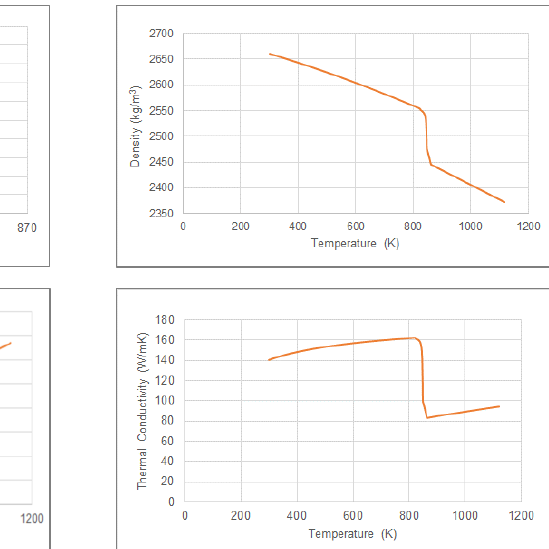
Figure 6. Thermo-physical properties obtained.